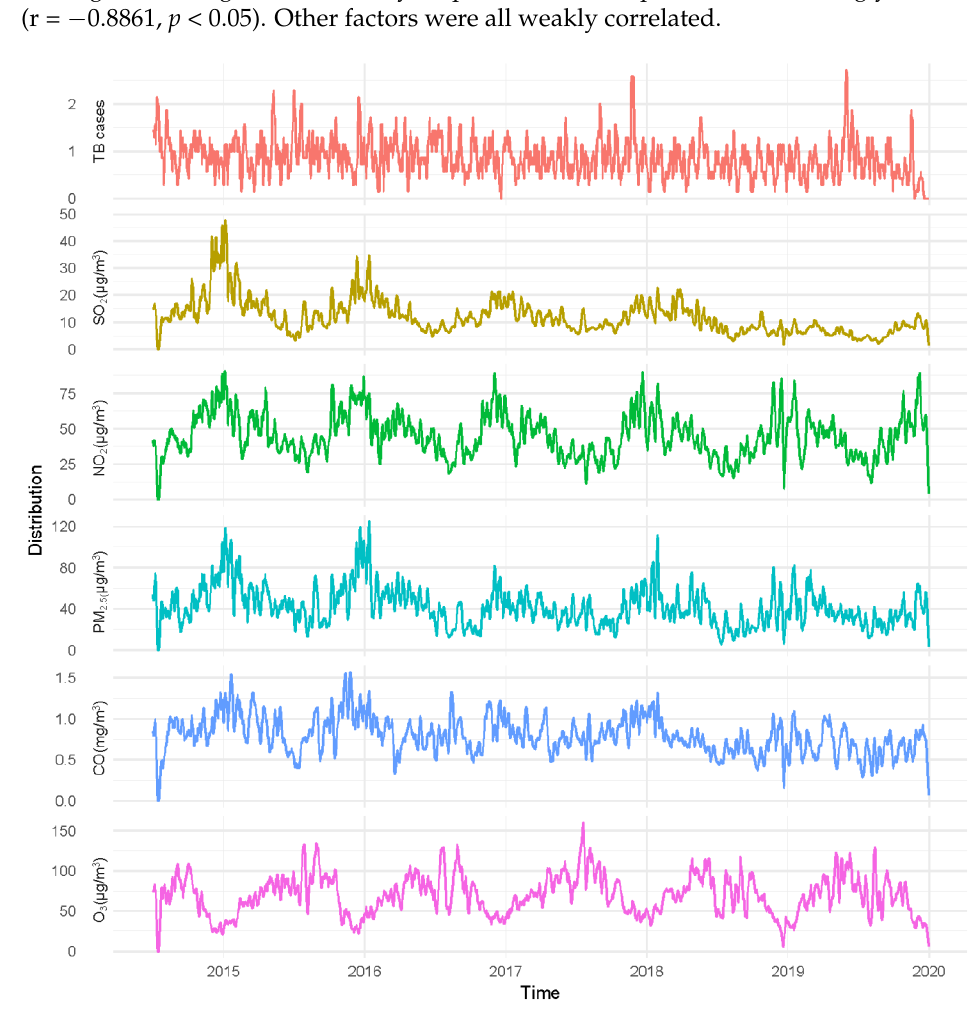
Figure 1. Time series of 7-day moving average number of TB cases and concentrations of air pollu- tants in Shanghai, China, from 2014 to